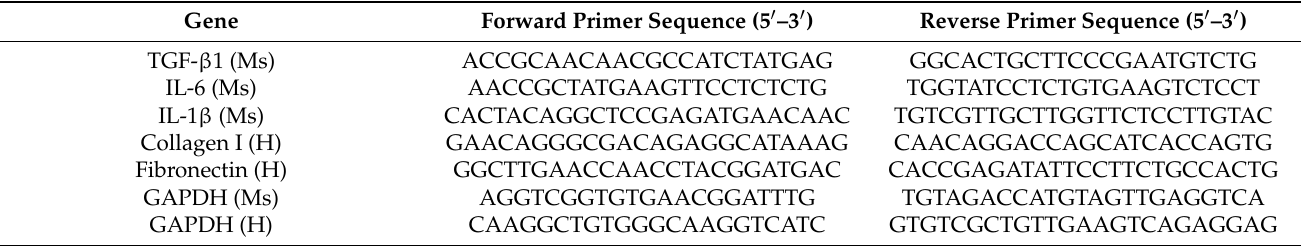
Table 1. RT-PCR primer